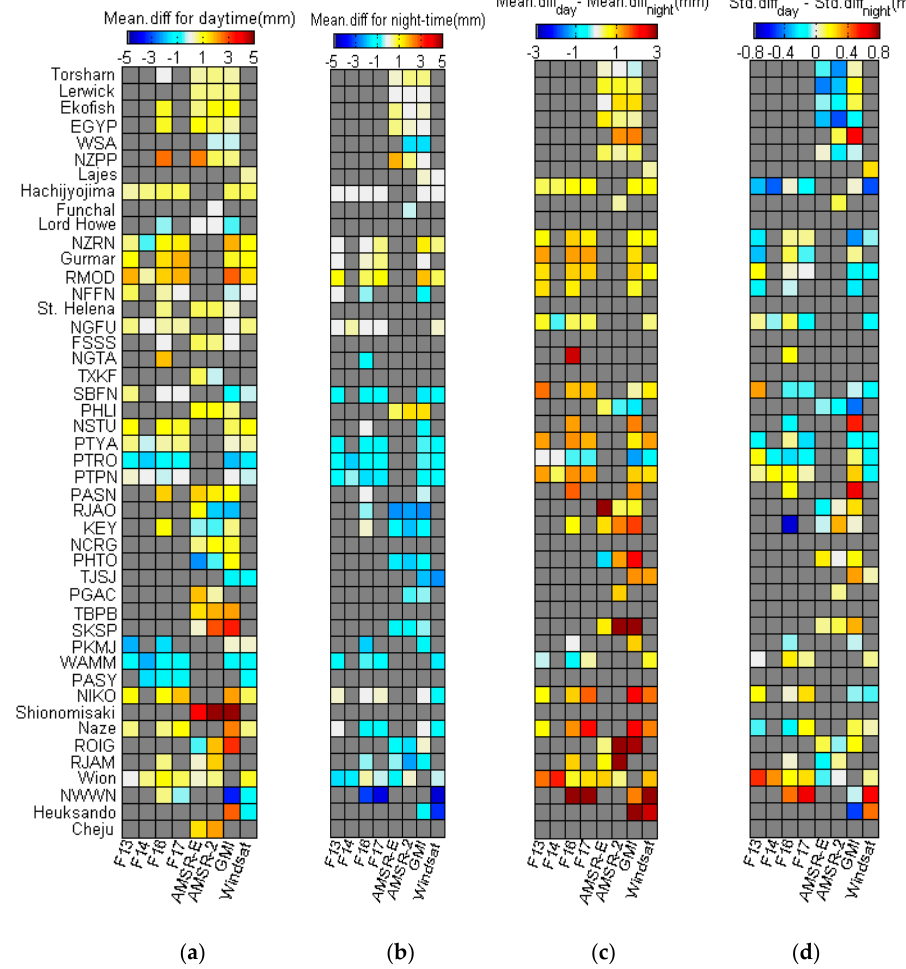
Figure 9. Summary statistics of TPW day–night differences for each satellite–RS station pair. ( a ) mean values of the difference for daytime; ( b ) mean values of the difference for night-time; ( c ) differences between the mean differences for day and night; ( d ) differences between the standard deviations for day and night.